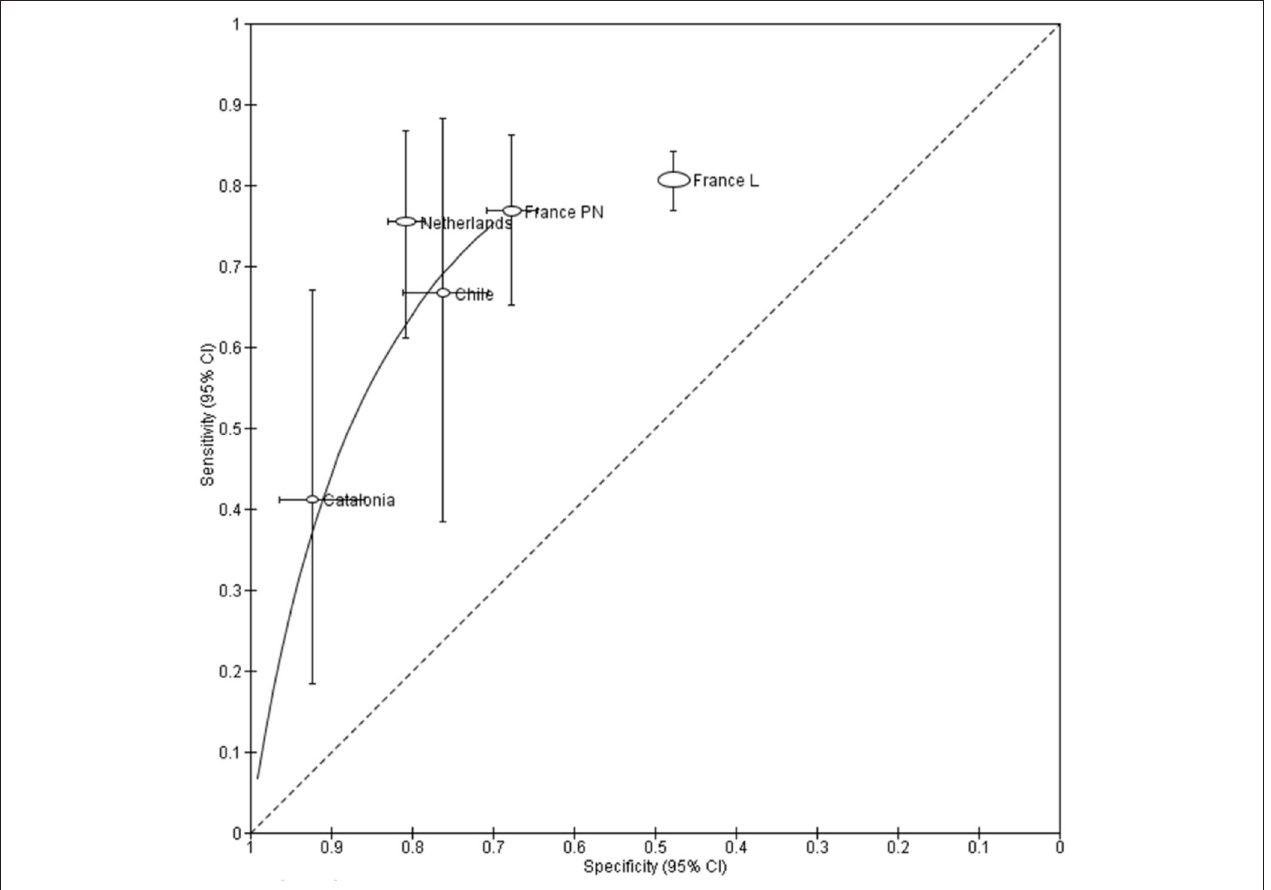
FIGURE 3 | Summary receiver operating characteristic curve of early developmental screening questionnaires for identifying any cognitive impairment or academic difficulty. Each marker displays the study and is scaled according to the sample size; the line represents the confidence interval. France PN, France Poitiers & Nancy; France L, France